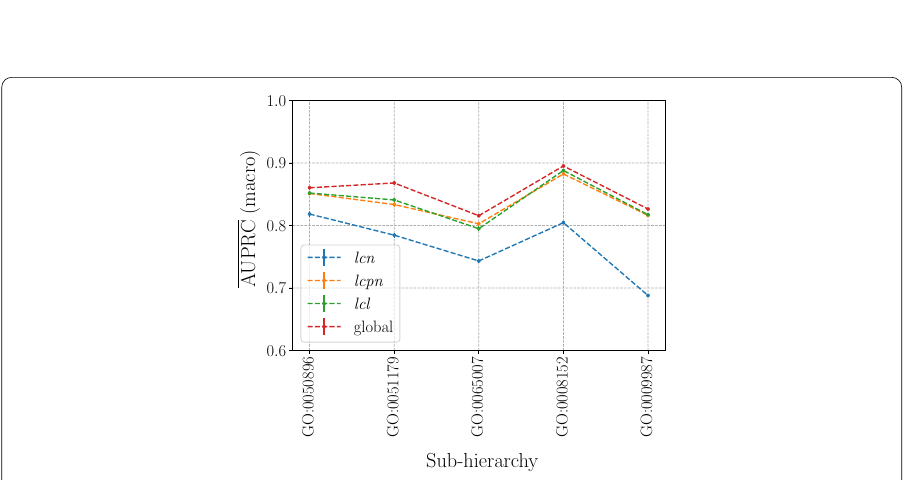
Fig. 7 Prediction performance of the proposed approach measured with the average area under the PR curve, i.e., AUPRC . The performance is measured independently per